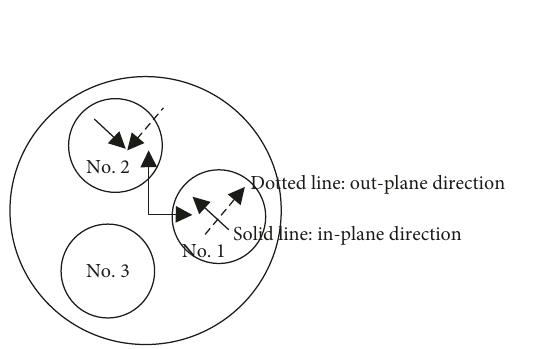
Figure 2: Sketch of the three-cylinder